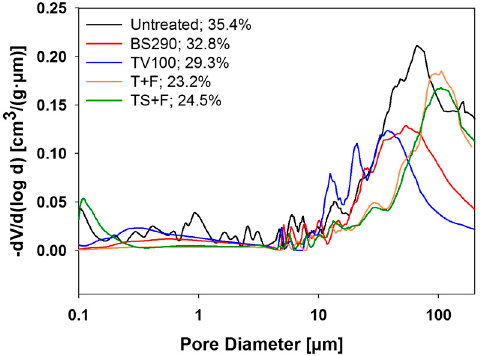
Figure 5. Pore size distribution obtained by mercury intrusion porosimetry (MIP) of the treated biocalcarenite samples and their untreated counterpart. Total porosity values (%) are also included after the corresponding treatment legend.